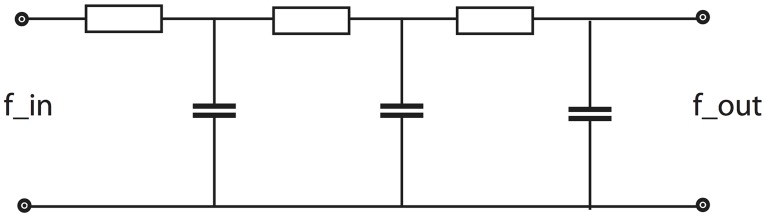
Electric wiring diagram consisting of a set of resistors and capacitors that emulate a series of first-order integrators coupled in cascade.Here, we regard the time-varying voltage f
in as representing the time varying input signal and the resulting output voltage f
out as representing the time varying output signal at a coarser temporal scale. According to the theory of temporal scale-space kernels for one-dimensional signals (Lindeberg [42]; Lindeberg and Fagerström [44]), the corresponding equivalent truncated exponential kernels are the only primitive temporal smoothing kernels that guarantee both temporal causality and non-creation of local extrema (alternatively zero-crossings) with increasing temporal scale. Such first-order temporal integration can be used as a straightforward computational model for temporal processing in biological neurons; see also (Koch [46], chapters 11–12) regarding physical modelling of the information transfer in dendrites of neurons.